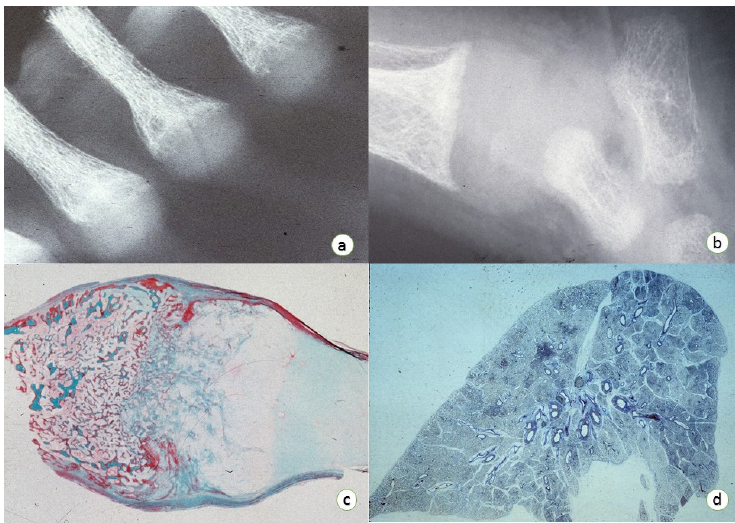
Figure 1. Rickets and pneumonia: ( a ) Roentgenogram of the anterior chest showing prominent costo ‐ chondral junctions. The anterior chest was cut to obtain tissue for plastic and paraffin embedding. ( b ) Roentgenogram of the right ankle showing wide and concave distal end of tibia. The distance from the distal end of the tibia to the tarsal bones is increased due to the large “rachitic metaphysis”, which is not calcified and does not appear on the roentgenogram. The radiographic change corresponds to the palpable thickening of the ankles on physical examination. ( c ) Histology of the right femur showing the expansion of the growth plate identified at the 6th costo ‐ chondral region (×2.5 original magnification, Masson’s trichromic stain). ( d ) Whole ‐ mount of the lung of an infant with rickets showing lobar pneumonia (personal archived material, C. Sergi).